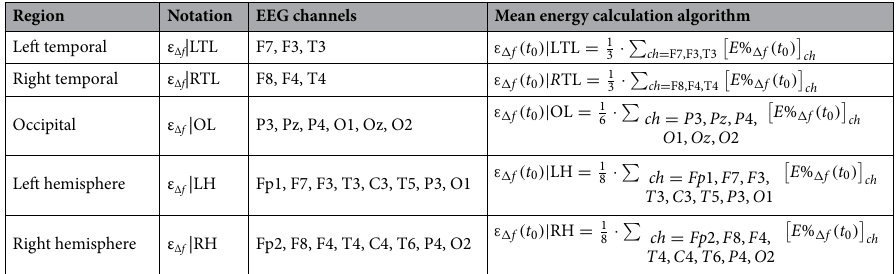
Table 2. Estimates of mean energy for oscillatory modes in the frequency ranges ∆δ, ∆θ, ∆α, ∆β1, ∆β2, and ∆γ for the scalp spatial regions of the right and left temporal lobes, and occipital lobe, as well as of the right and left hemispheres. These spatial regions are shown in Fig.